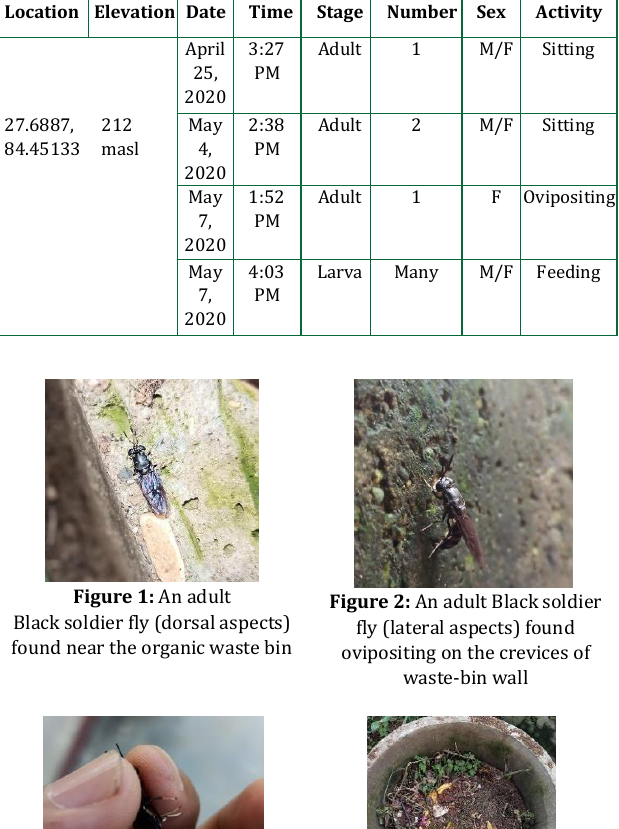
Table 1: Details of Incidence of Black soldier fly Location Elevation Date Time Stage Number Sex